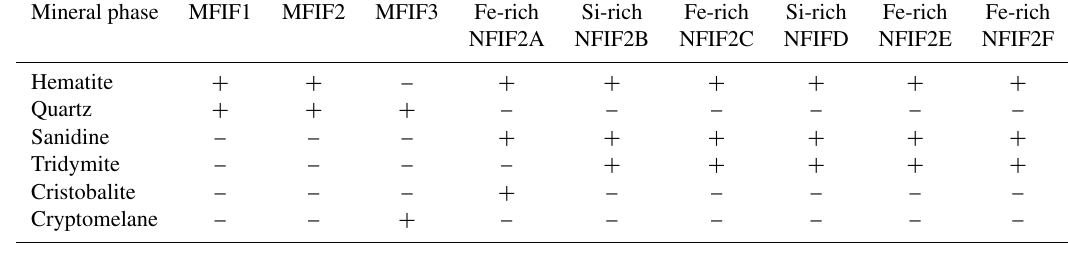
Table 1. Results of X-ray diffraction (XRD) analysis showing major mineralogical compositions: NFIF (nonfossiliferous iron formation) and MFIF (microfossiliferous iron formation).